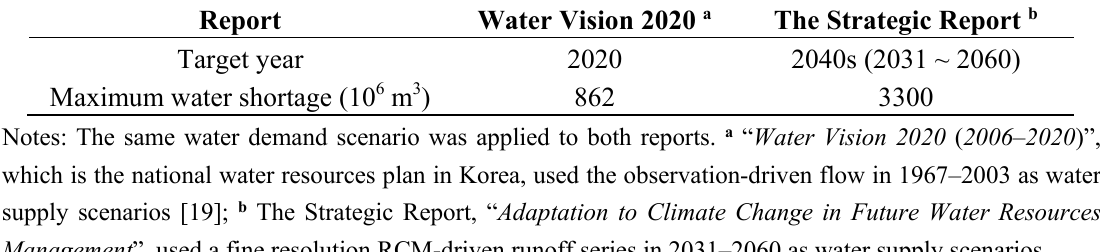
Table 1. Water shortage projection of previous studies in